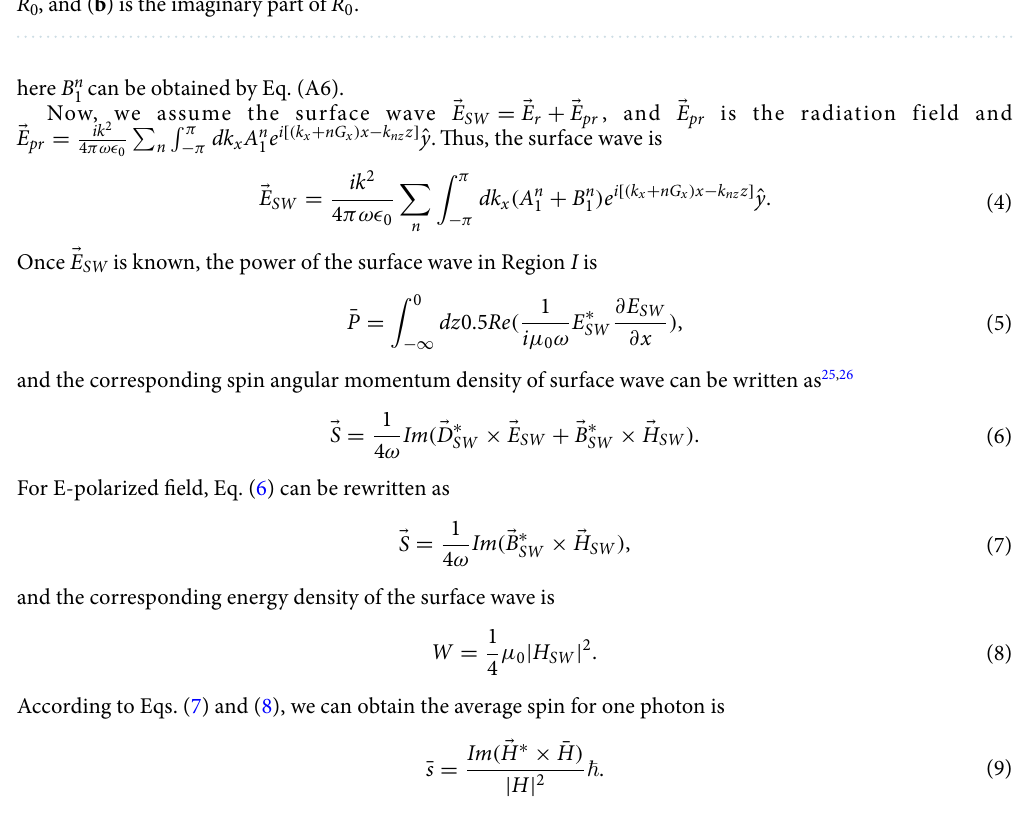
Figure 2. Reflection coefficients R 0 for ω = 0.3 ( 2 π c / a ) as a function of k x for different periodic layer number N of the PC slab, black curve for N = 6 , red curve for N = 8 , and green curve for N = 20 , ( a ) is the real part of R R 0 , and ( b ) is the imaginary part of 0